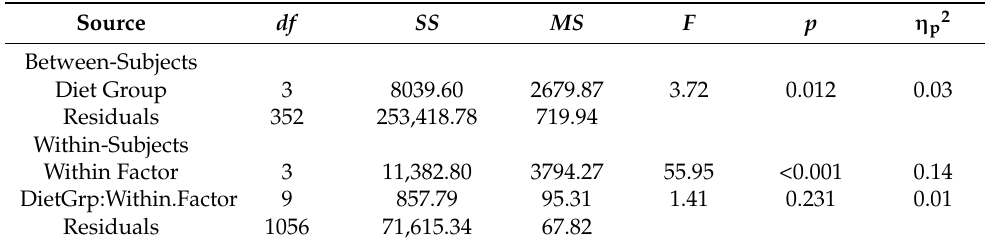
Table 11. Mixed model ANOVA average Symptom Score by month with within-factor diet groups.